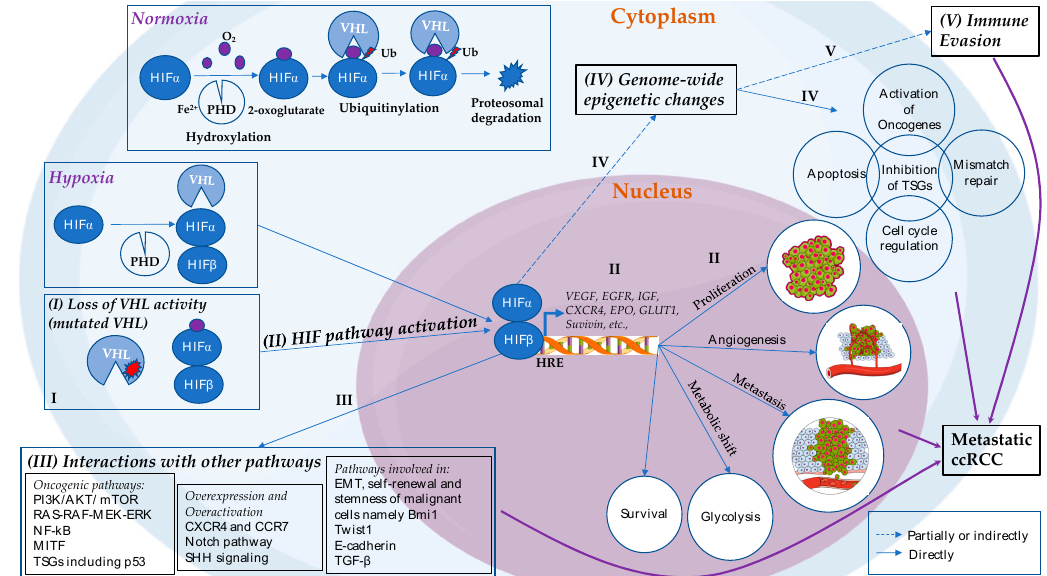
Figure 1. Physiology of the VHL-HIF pathway along with proposed etiopathogenesis that leads to metastatic ccRCC. In normoxia, HIF α hydroxylation is carried out by PHDs that requires iron, ascorbate and 2-oxoglutarate. PHD proteins use oxygen to add hydroxyl group on one of two conserved proline residues in the Oxygen Degradation Domain of the α -subunit of the HIF α molecule in order to mark it for recognition by pVHL. pVHL then recognizes hydroxylated HIF α , ubiquitinylates it and targets it for proteasomal degradation. However, in hypoxia, hydroxylation step by PHDs does not happen, resulting in HIF α stabilization. HIF α accumulates in the cytoplasm, forms complex with constitutionally expressed HIF β , and eventually translocates into the nucleus where is binds to HREs, thereby activating hundreds of genes related to adaptation to a low oxygen environment.